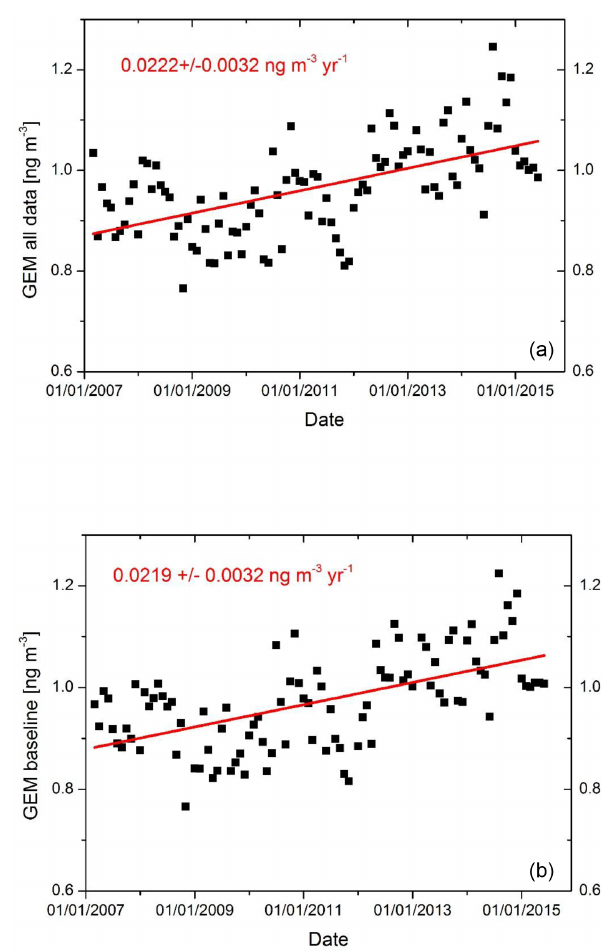
Figure 1. Monthly average GEM concentrations and their least- squares fit: upper panel – all data; lower panel – baseline data (i.e., only GEM concentrations at 222 Rn concentrations ≤ 250mBqm − 3